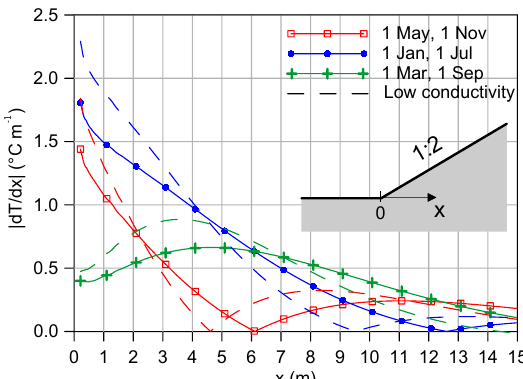
Figure 16. Temperature at the base of a 1:2 slope from finite ele- ment modelling.